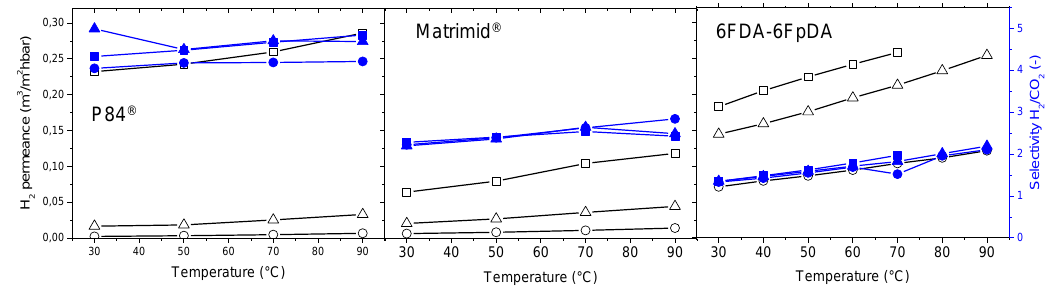
Figure 12. Separation properties of the ceramic-supported thin film polymers for the H 2 /CO 2 separation as a function of the temperature and concentration of the polymer solution. Unfilled symbols represent the permeance (in the left y -axis) and filled symbols represent selectivity (in the right y -axis). Squares represent 5% solution, triangles 7.5%, and circles 10%.